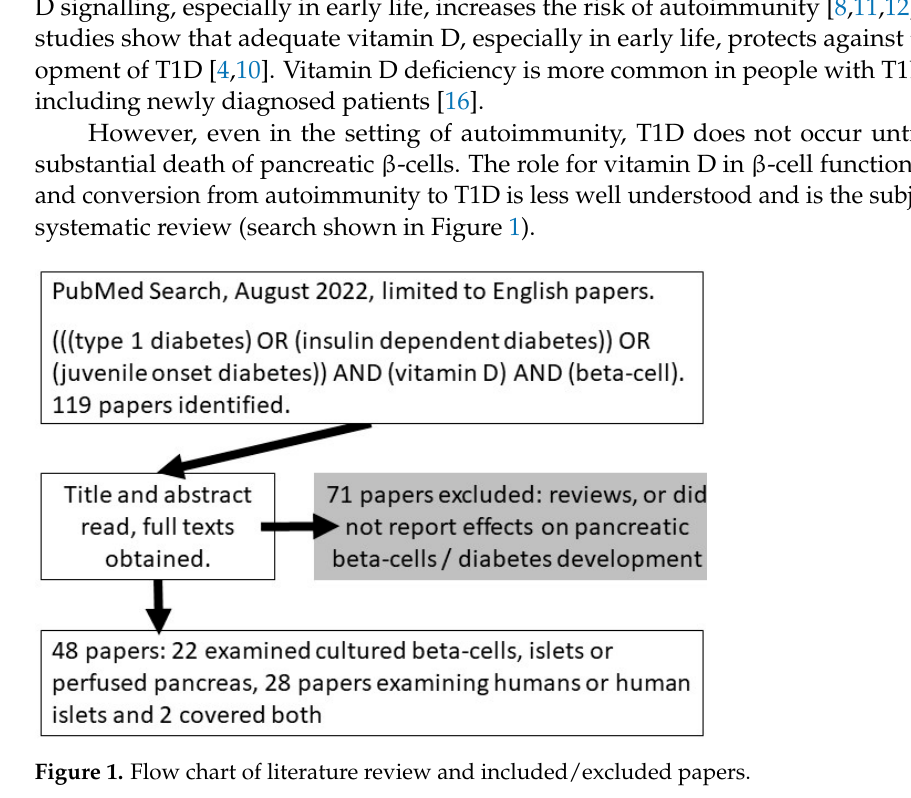
Figure 1. Flow chart of literature review and included/excluded papers.